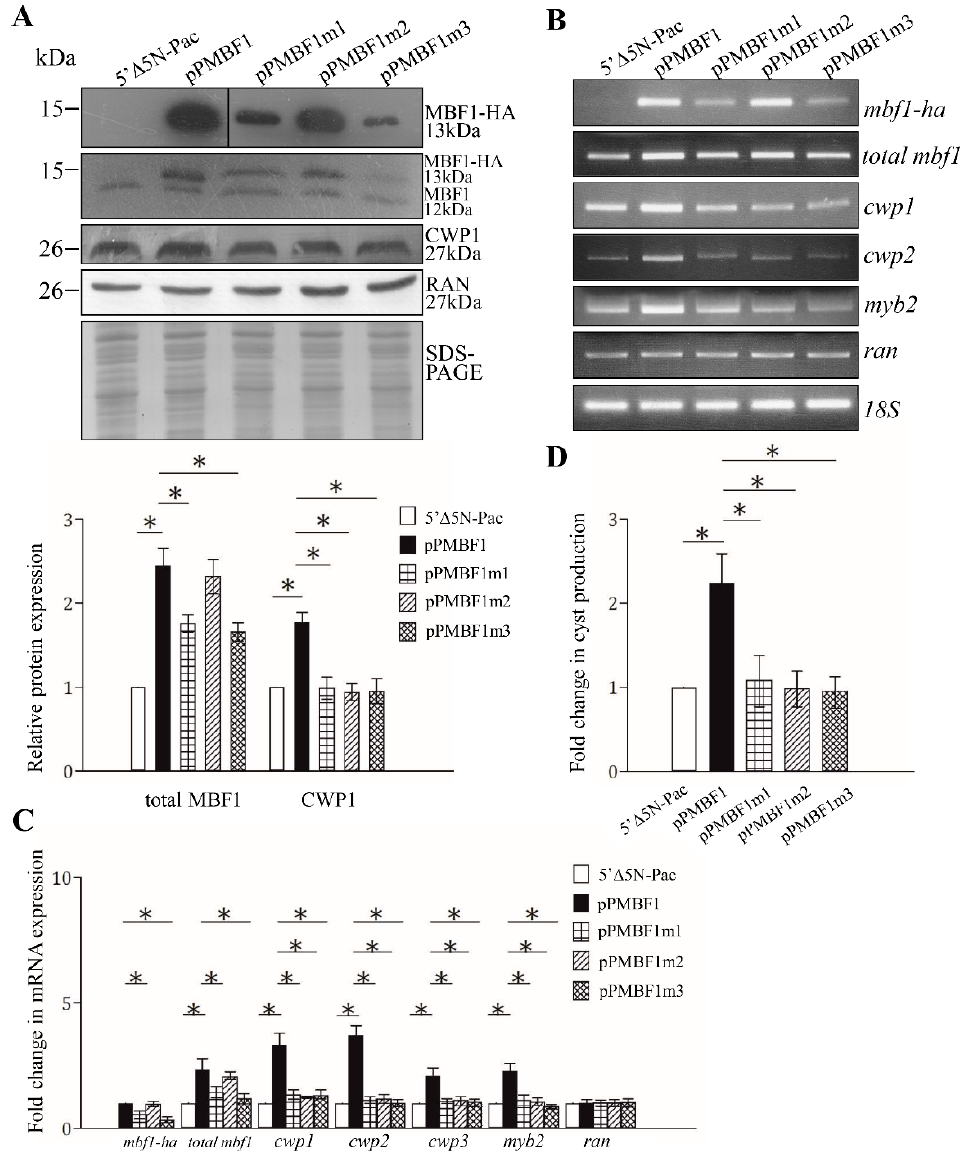
Figure 3. Increased expression of the cwp1-3 and myb2 genes in the MBF1-overexpressing cell line. ( A ) MBF1 overexpression increased the cyst wall protein 1 (CWP1) level. The mbf1 gene was mutated (Figure 1B) and subcloned to replace the wild-type mbf1 gene in the backbone of pPMBF1 (Figure 2C), and the resulting plasmids pPMBF1m1-3 were transfected into Giardia . The 5 ′∆ 5N-Pac, pPMBF1, and pPMBF1m1-3 stable transfectants were incubated in growth medium and then subjected to Western blot analysis using anti-HA, anti-MBF1, anti-CWP1, and anti-Ran antibodies, respectively. SDS-PAGE with Coomassie Blue staining is included as a control for equal protein loading. As a control, similar levels of the RAN protein were detected. The band intensity from triplicate Western blots was quantified using Image J. The MBF1 or CWP1 protein levels were normalized to the RAN loading control. The ratio of MBF1 or CWP1 protein levels in the specific cell line to levels in the 5 ′∆ 5N-Pac cell line is shown and expressed as mean ± 95% con- fidence intervals. *, p < 0.05. ( B ) RT-PCR assays of transcript expression in the MBF1- and MBF1 mutants- expressing cell lines. RNA was extracted from the 5 ′∆ 5N-Pac, pPMBF1, and pPMBF1m1-3 stable transfectants cultured in growth medium. RT-PCR was performed using primers for genes indicated in the figure. As a control, similar levels of the 18S ribosomal RNA (18S) were detected. ( C ) Quantitative real-time PCR assays of transcript expression in the MBF1- and MBF1 mutants- expressing cell lines. Real-time PCR was performed using primers for genes indicated in the fig- ure. Similar levels of the 18S ribosomal RNA were detected. The mRNA levels were normalized to the 18S ribosomal RNA levels. The ratio of mRNA levels in the pPMBF1 or pPMBF1m1-3 cell line